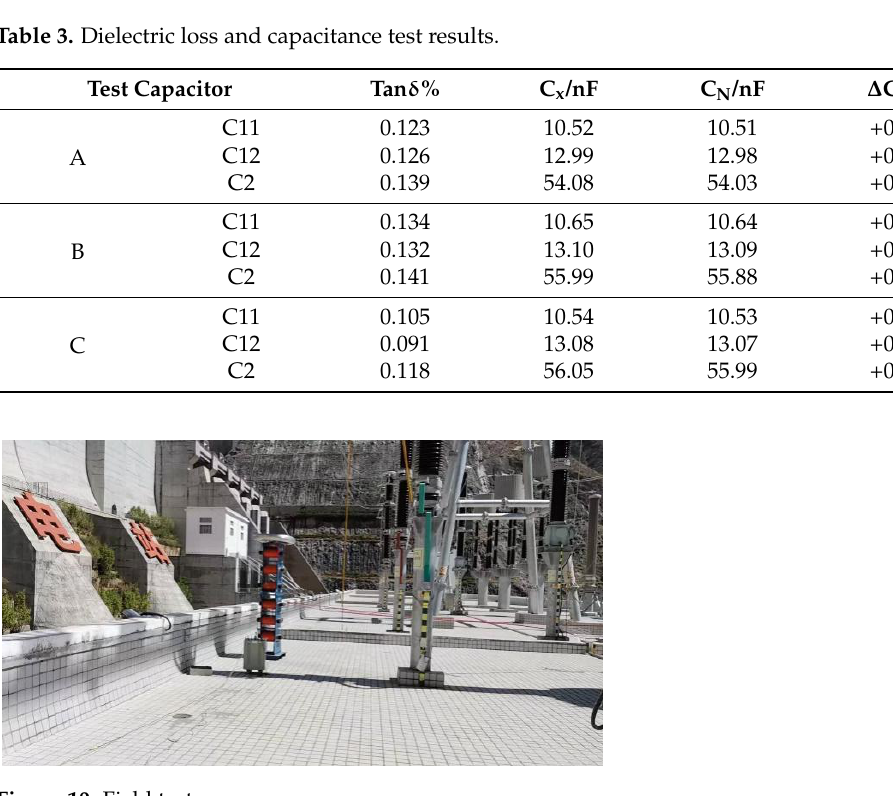
Figure 10. Field